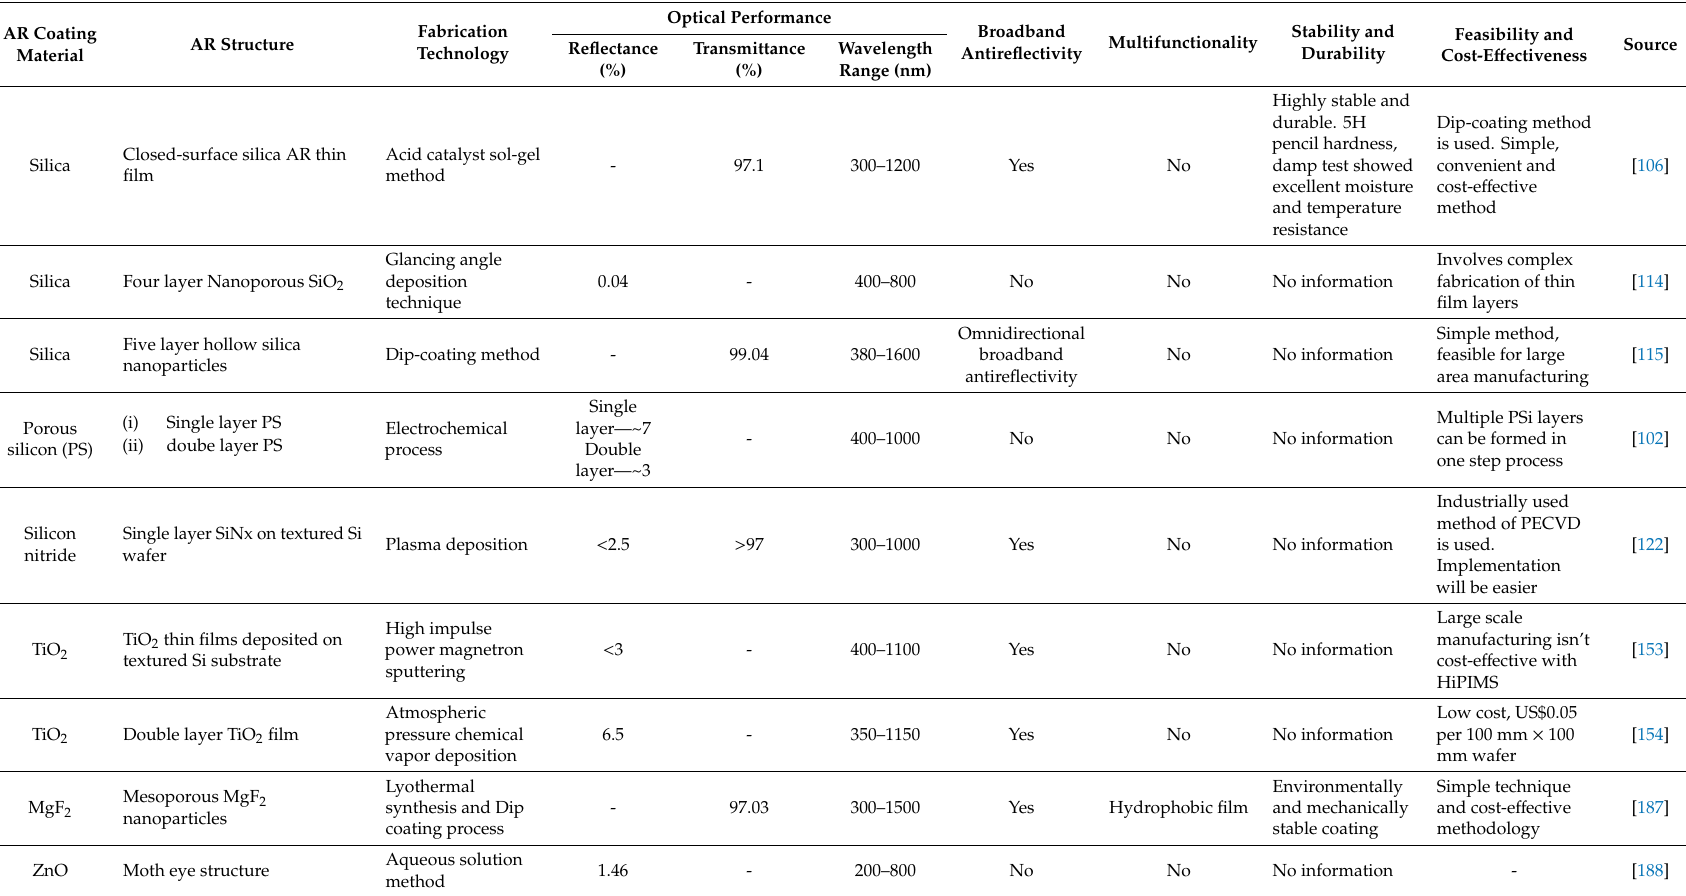
Table 9. Comparison of various high-performance coatings with respect to perfect AR coating